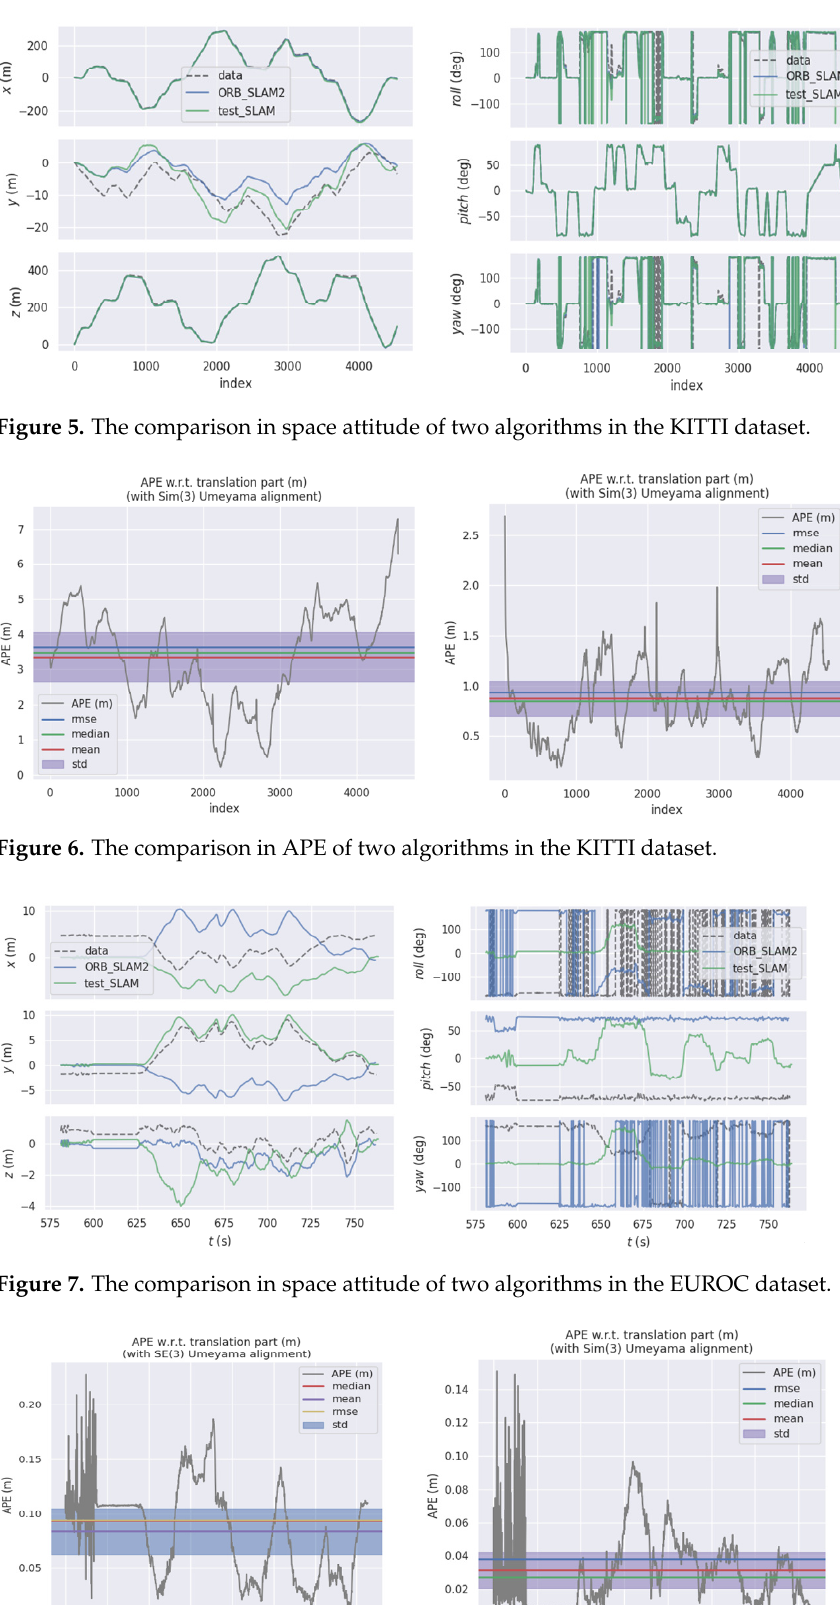
Figure 7. The comparison in space attitude of two algorithms in the EUROC dataset.